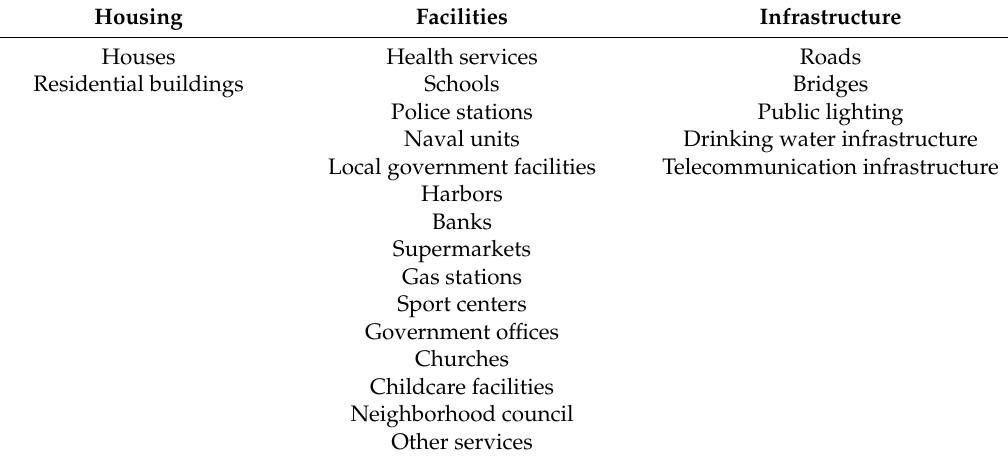
Table 2. Elements at